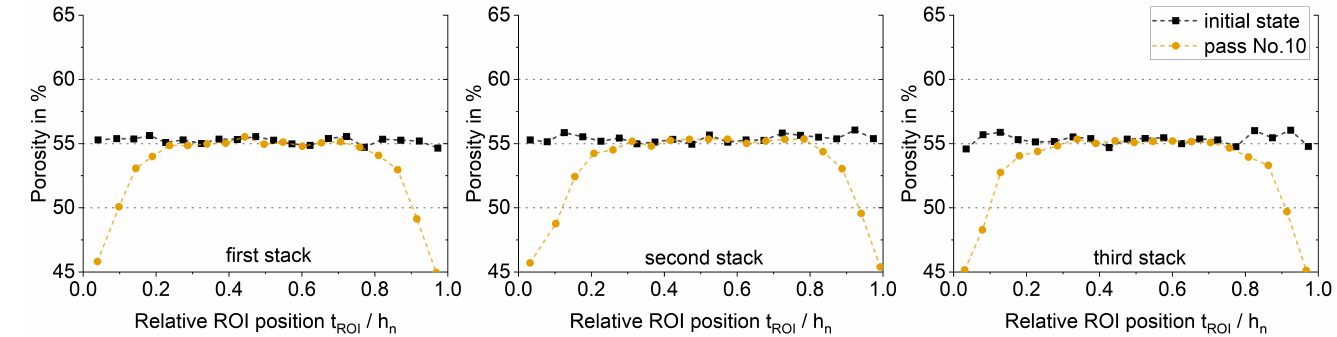
Figure A12. Series II: 20-0.05-10 ( l d / h m ≈ 0.2): Porosity change over relative sample depth (0=upper surface; 0.5= mid-section of sample; 1 =lower surface) due to rolling for first, second and third